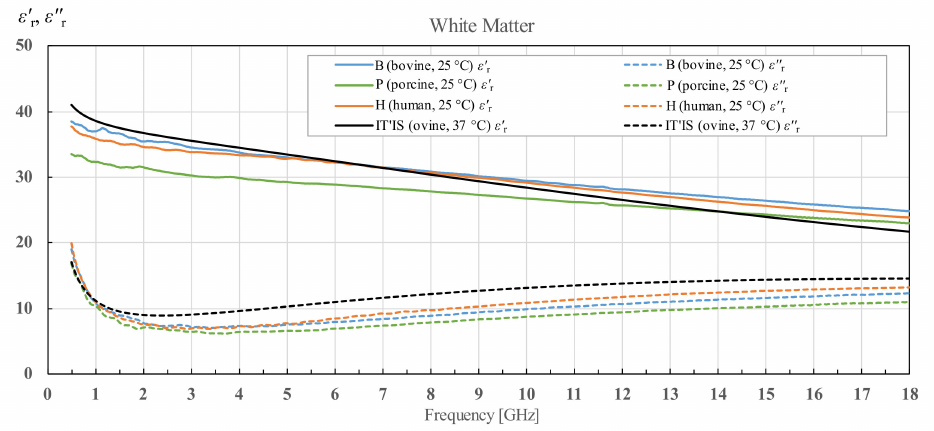
Figure 18. White matter permittivity comparison of averaged bovine brains (B), averaged hu- man brains (H) and a porcine brain (P), as well as comparison with the published data from IT’IS database [21].